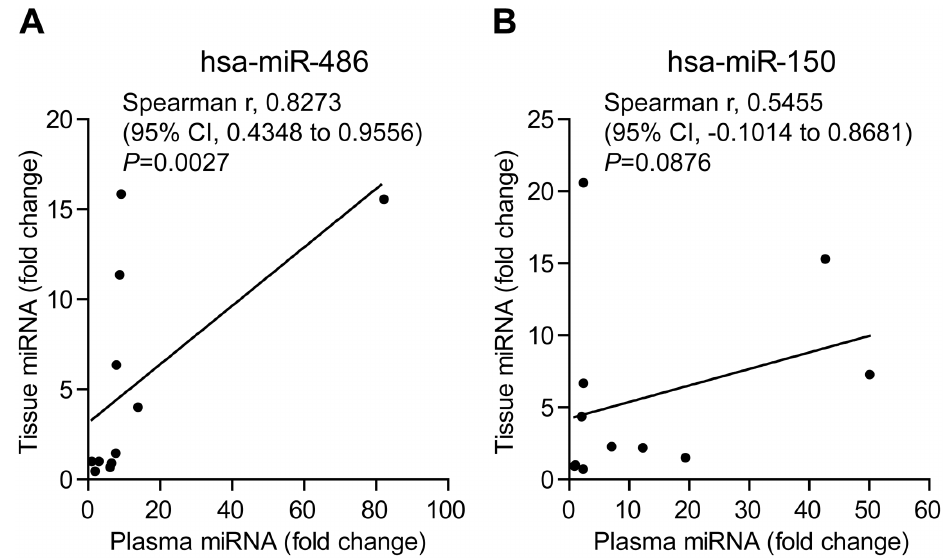
Fig 2. Correlation of plasma levels and tissue expressions of miR-486 and miR-150. Correlation analyses for plasma and tissue levels of miR-486 and miR-150 was performed with GraphPad Prism 5.0 software. (A) Spearman ’ s correlation coefficient analysis of plasma and tissue miR-486 levels. (B) Spearman ’ s correlation coefficient analysis of plasma and tissue miR-150 levels.